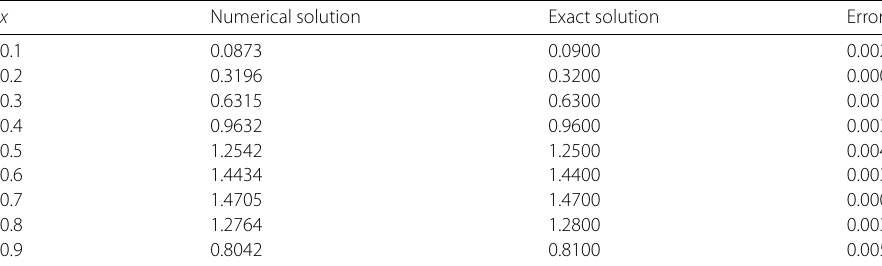
Table 1 Numerical solution, exact solution, and absolute error at T = 1.0 of